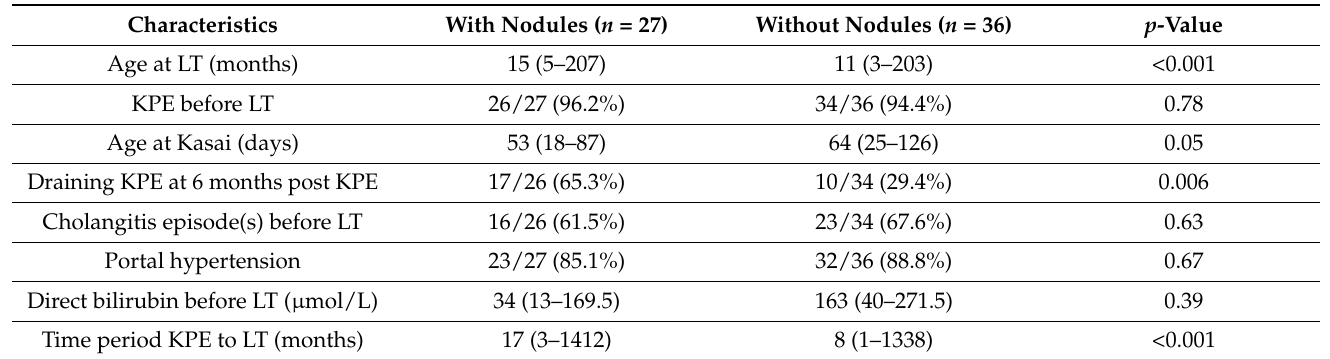
Table 3. Characteristics of biliary atresia patients with and without nodules on liver explant. KPE, Kasai hepatoportoenterostomy; LT, liver